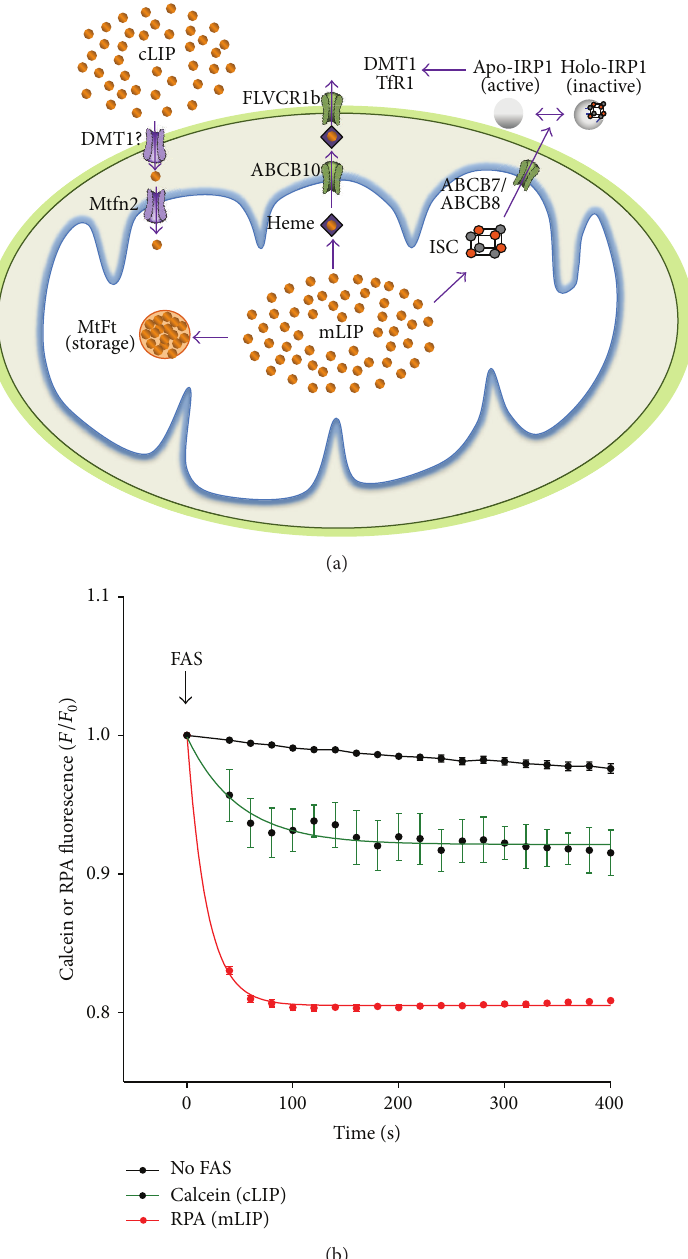
Figure 1: (a) Mitochondrial iron traffic. Iron enters mitochondria from the cLIP in a process mediated by the inner mitochondrial iron transporter Mtfn2 and probably by DMT1 located in the outer membrane. Upon entering, iron incorporates into the mLIP from where it distributes for heme and ISC synthesis or for storage in mFt. Heme leaves the mitochondrion through ABCB10 and the mitochondrial heme exporter FLVCR1b, located in the inner and outer mitochondrial membranes, respectively. ISCs are transported out of the mitochondrion by the ABCB7 transporter and probably by the ABCB8 transporter as well. In the cytoplasm, ISCs bind to the corresponding apoproteins. IRP1 binds a 4Fe-4S cluster; the holoprotein is inactive to induce the transcriptional regulation of cell iron-import proteins like DMT1 and TfR1. In contrast, apo-IRP1, normally abundant under low cell iron conditions, upregulates the expression of iron-import proteins like DMT1 and TfR1. ABC: ATP-binding cassette transporter; cLIP: cytoplasmic labile iron pool; DMT1: divalent metal transporter 1; FLVCR1b: feline leukemia virus subgroup C receptor 1B transporter; ISC: iron-sulfur cluster; mFt: mitochondrial ferritin; mLIP: mitochondrial iron pool; Mtfn2: mitoferrin-2; TfR1: transferrin receptor 1. (b) Kinetic determination of iron entrance into the cLIP and mLIP. SH-SY5Y cells preloaded with the mitochondrial iron sensor rhodamine B-[(1,10-phenanthroline-5-yl)aminocarbonyl]benzyl ester (RPA) and the cytoplasmic iron sensor calcein were challenged with 40 𝜇 M ferrous ammonium sulfate (Fe) and changes in RPA and calcein fluorescence were followed in a multiplate fluorescence reader [61, 62]. Iron binding quenches RPA and calcein fluorescence; thus, a decrease in RPA or calcein fluorescence is directly proportional to iron entrance into the mLIP or cLIP, respectively. Note that the initial rate of iron entrance into the mLIP ( 𝐾 = )/ sec) is larger than the rate of iron entrance into the cytoplasmic LIP ( 𝐾 = 0.0206 ± 0.0070Δ(𝐹/𝐹 )/ sec). Values 0.0536 ± 0.0021Δ(𝐹/𝐹 0 0 represent mean ± SD of quadruplicates; 𝑃 = 0.004